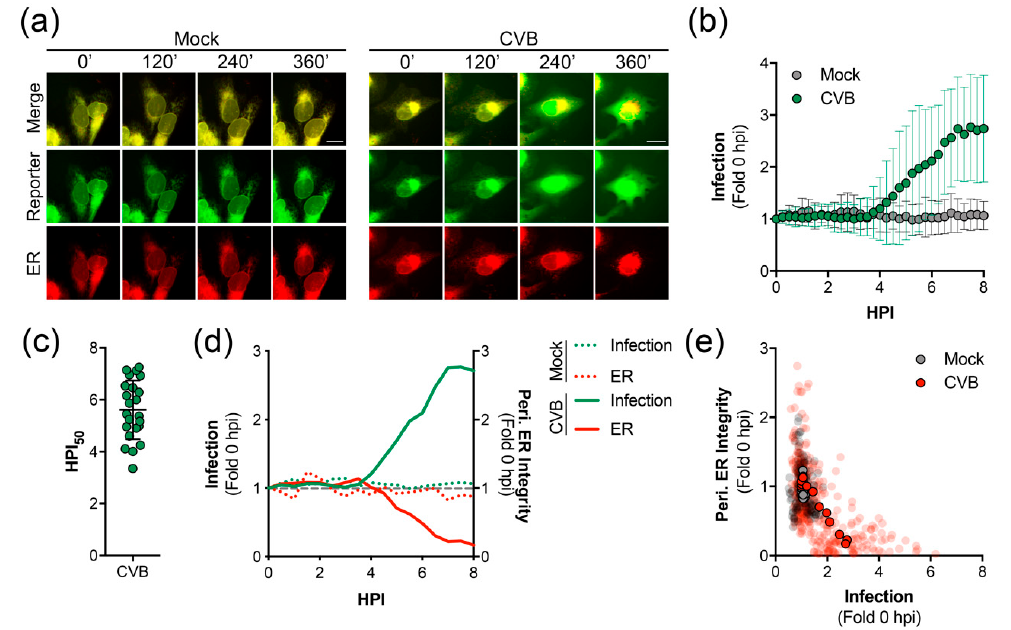
Figure 2. Time-lapse imaging of CVB infected cells expressing RepER. ( a ) Representative time-points of an image series from live-cell imaging of GFP (reporter, green), mCherry (ER, red), and merged